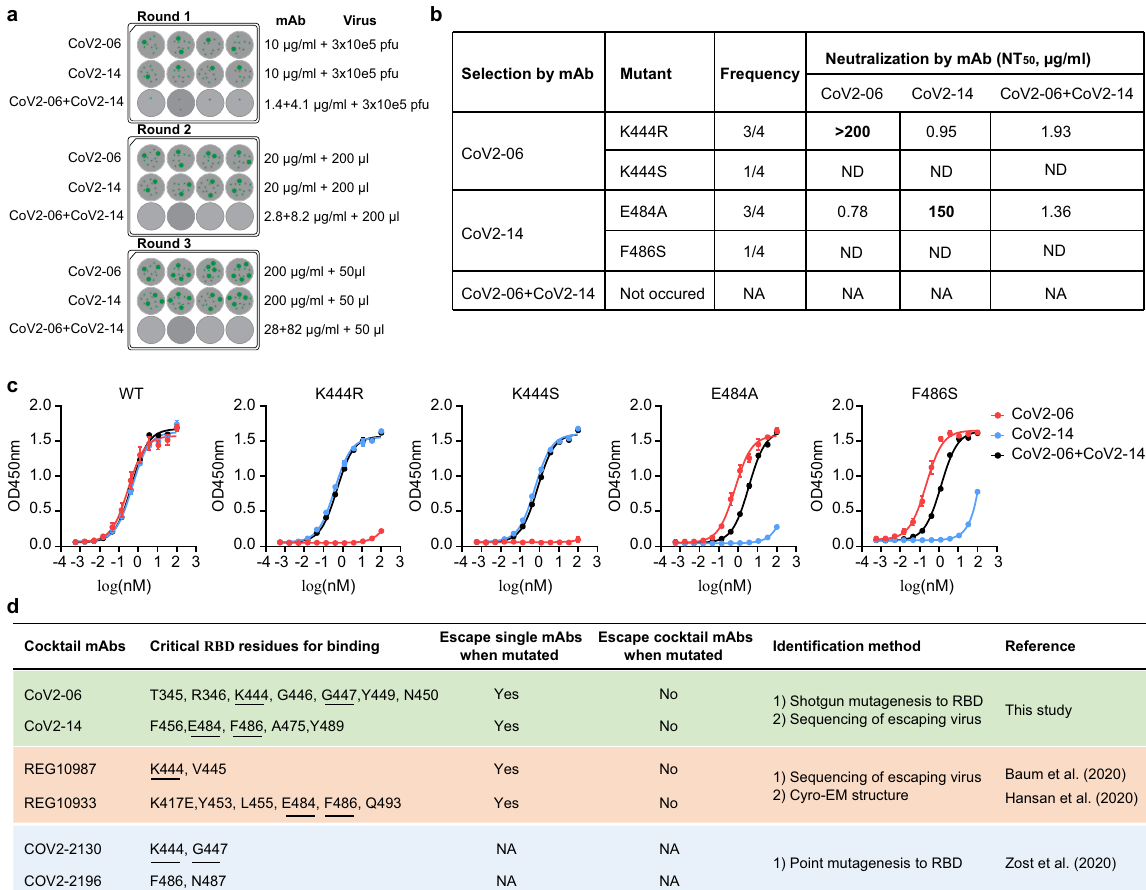
Fig. 5 CoV2-06 and CoV2-14 cocktail prevents escape mutation of live SARS-CoV-2. a Schematic diagram for the procedures of evaluating SARS-CoV-2 escape mutation under individual or cocktail mAbs. Green dots represent cell clusters expressing the mNeonGreen due to viral infection. b The mutated RBD residue, occurring frequency, and mAb neutralization of the mutant viruses. ND not determined, NA not available. c ELISA binding curves of indicated mAb to wild-type (WT) or mutant sCoV2-RBD proteins. Data points are mean ± SD of two replicates. d Summary of the key residues, the ability to inhibit mutant virus, and the methods of identifying the critical residues for cocktail mAbs in this study and published studies.